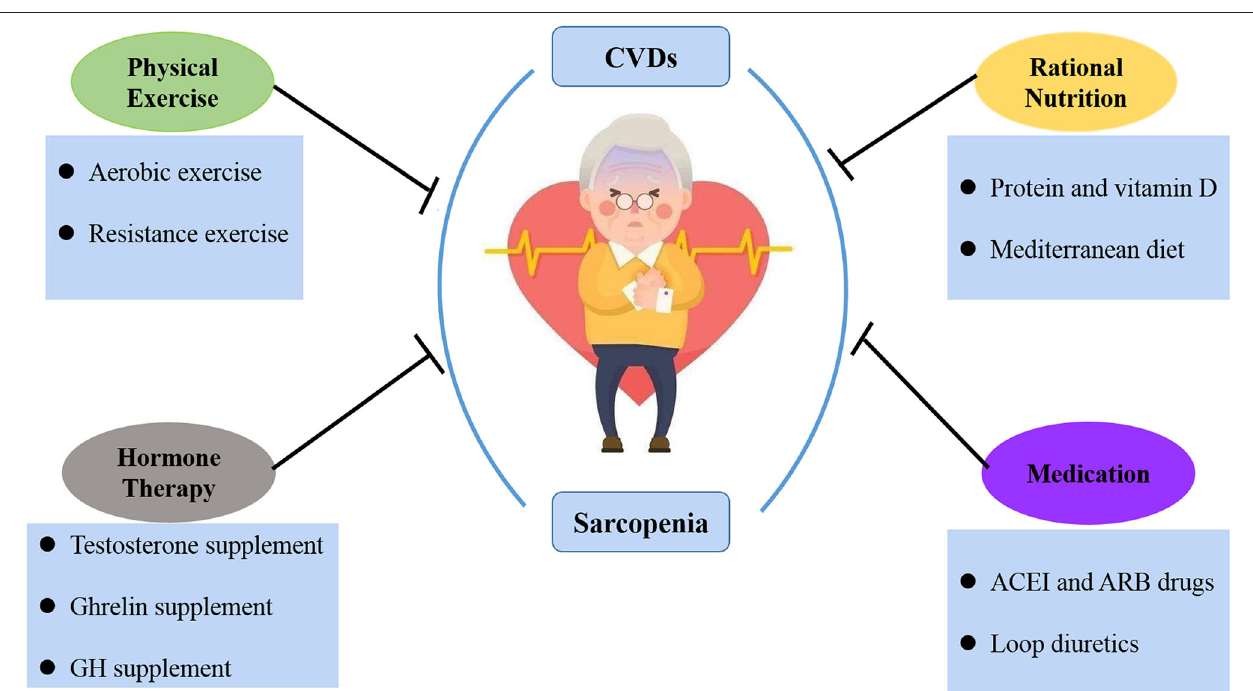
FIGURE 2 | The treatment of sarcopenia and CVDs. At present, the joint intervention of sarcopenia and CVDs is mainly from physical exercise, rational nutrition, hormone therapy and